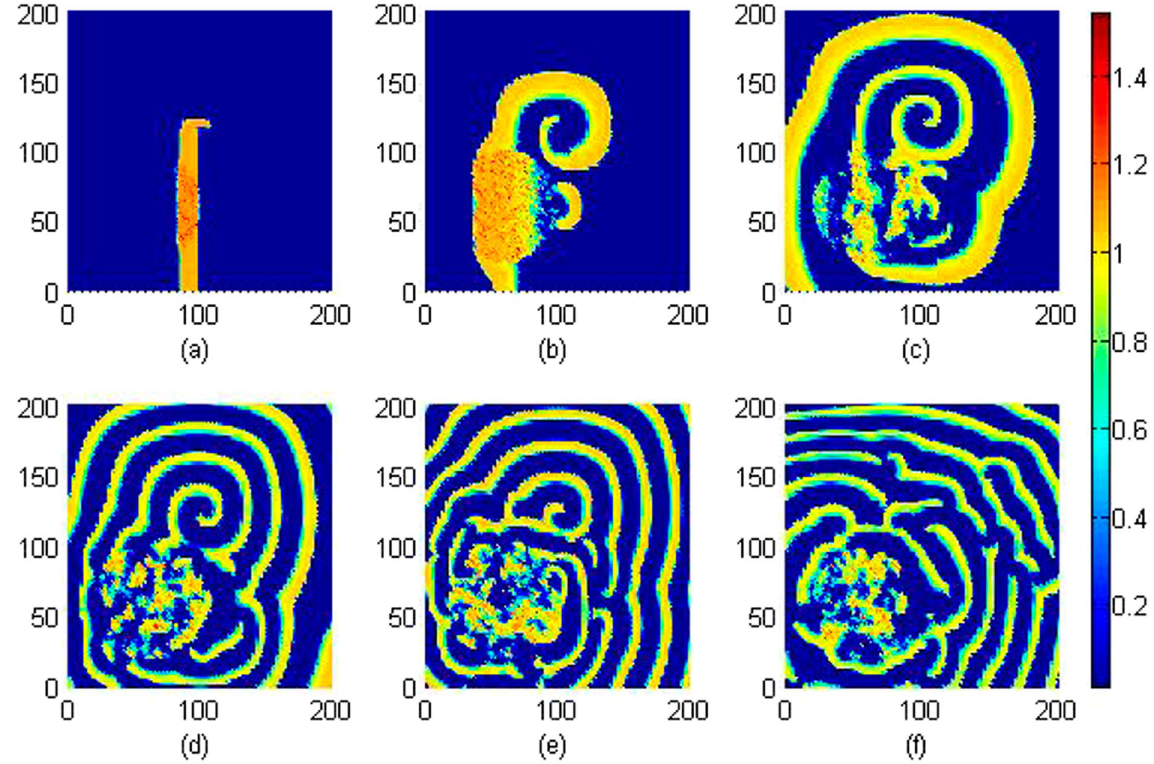
Figure 12. Developed spatial pattern is plotted for the media by setting wedge-shaped initial values, and the center of area exposed to electromagnetic field is selected as ( x 0 , y 0 ) = (60,60), r ≤ 40, noise intensity is set as D = 9, and parameters are selected as k 0 = 0.1, k 1 = 0.5, k 2 = 1.6, α = 1, β = 2. For t = 10 ( a ), 60 ( b ), 120 ( c ), 200 ( d ), 400 ( e ), 800 ( f ) time